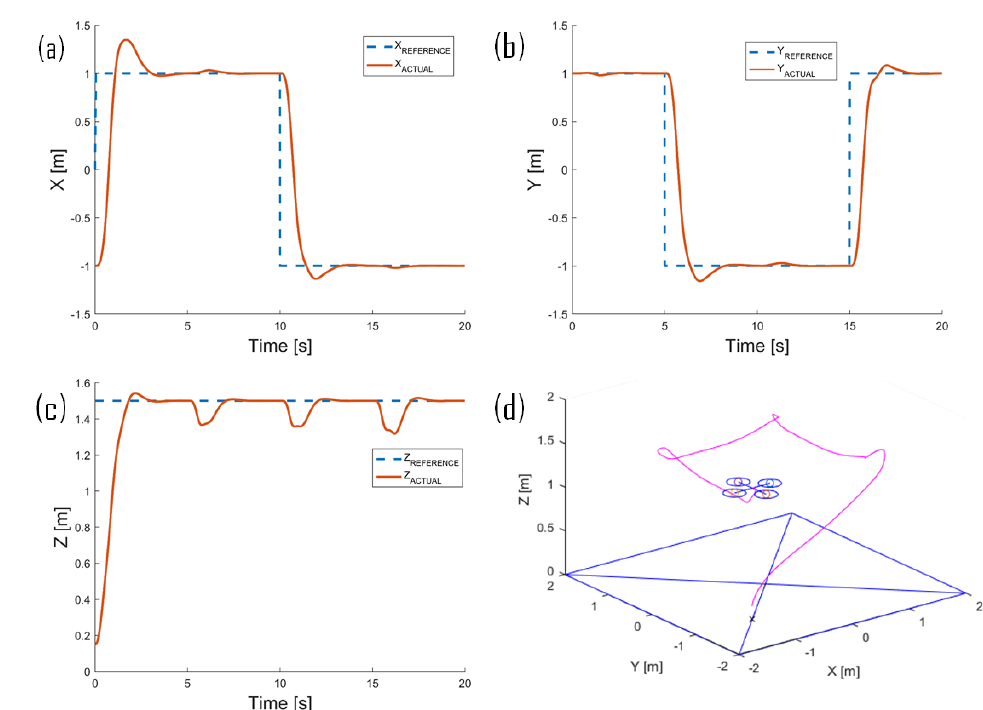
Figure 7. Experiment No. 1: An exemplary test of the effectiveness of square-shaped path tracking for the X-4 Flyer II drone model in a system with BELBIC controllers tuned by trial and error: ( a – c ) reference (desired) and actual (measured) positions of the UAV on the X , Y , and Z axes, ( d ) flight trajectory in